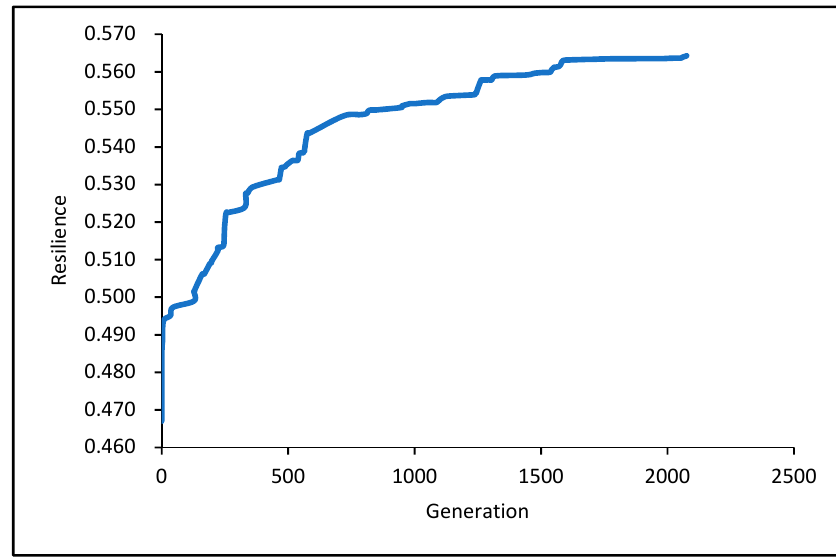
Figure 11. Convergence of the genetic algorithm optimization model.